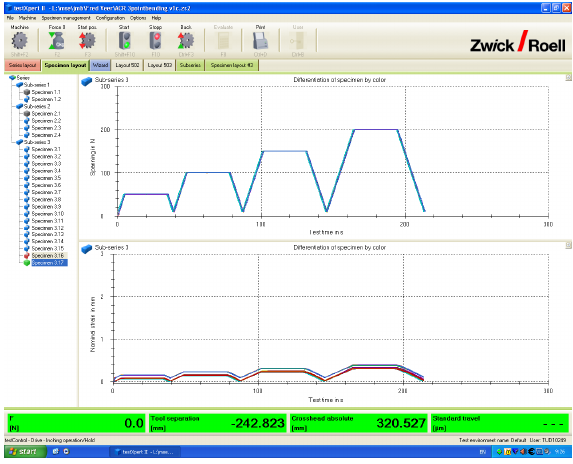
Figure 2: Load sequence for glass